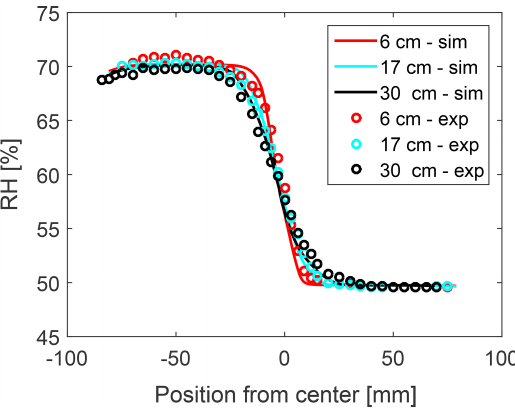
Figure 8. RH profiles for (cid:49)T = 10K and (cid:49)T d = 4K based on tem- perature and dew-point temperature measurements for z = 6, 17 and 30cm including numerical